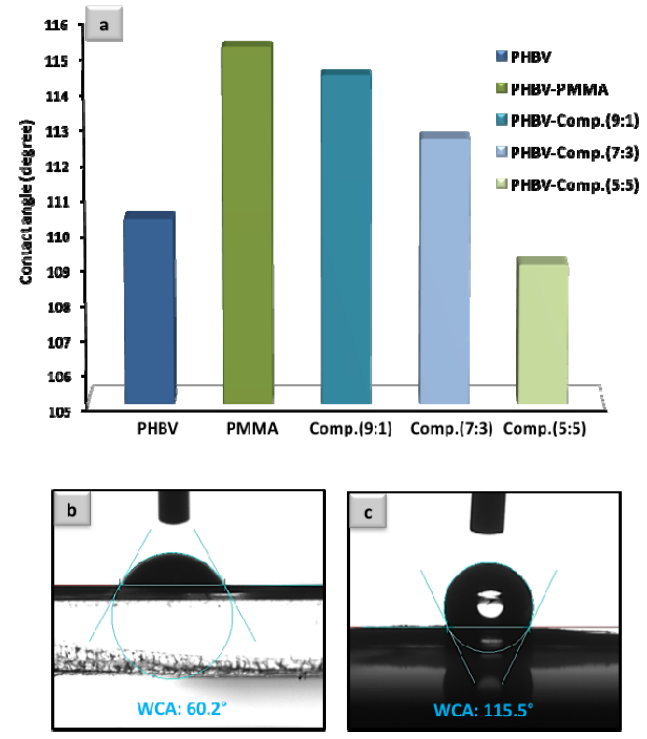
Figure 3. Water ‐ in ‐ air contact angle (WCA) analysis of the coated and uncoated PHBV fibers: ( a ) results with excluded (negligible) standard deviations; ( b ) droplet images of the contact angles measured for a commercial 96 ‐ well plate made from PS (polystyrene); and ( c ) representative droplet image on PMMA ‐ coated PHBV electrospun fiber mat.